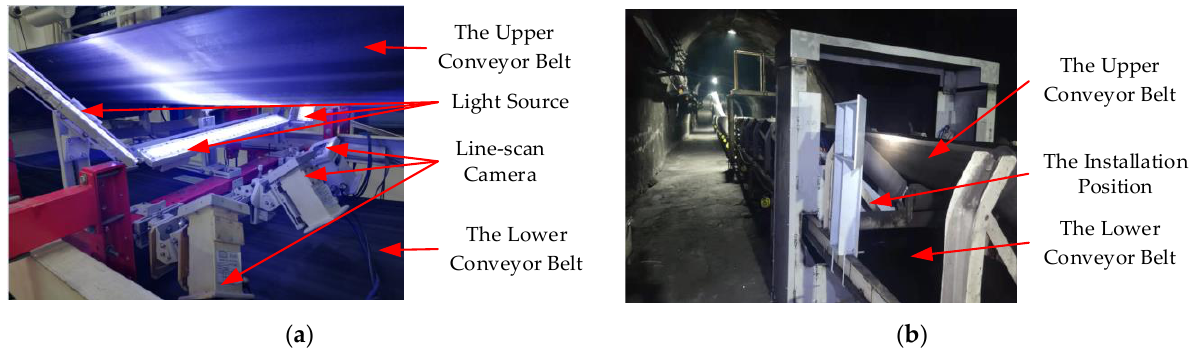
Figure 2. Installation position of upper belt image acquisition device on the conveyor. ( a ) Picture of the device installed in the laboratory. ( b ) Picture of device installed on site.